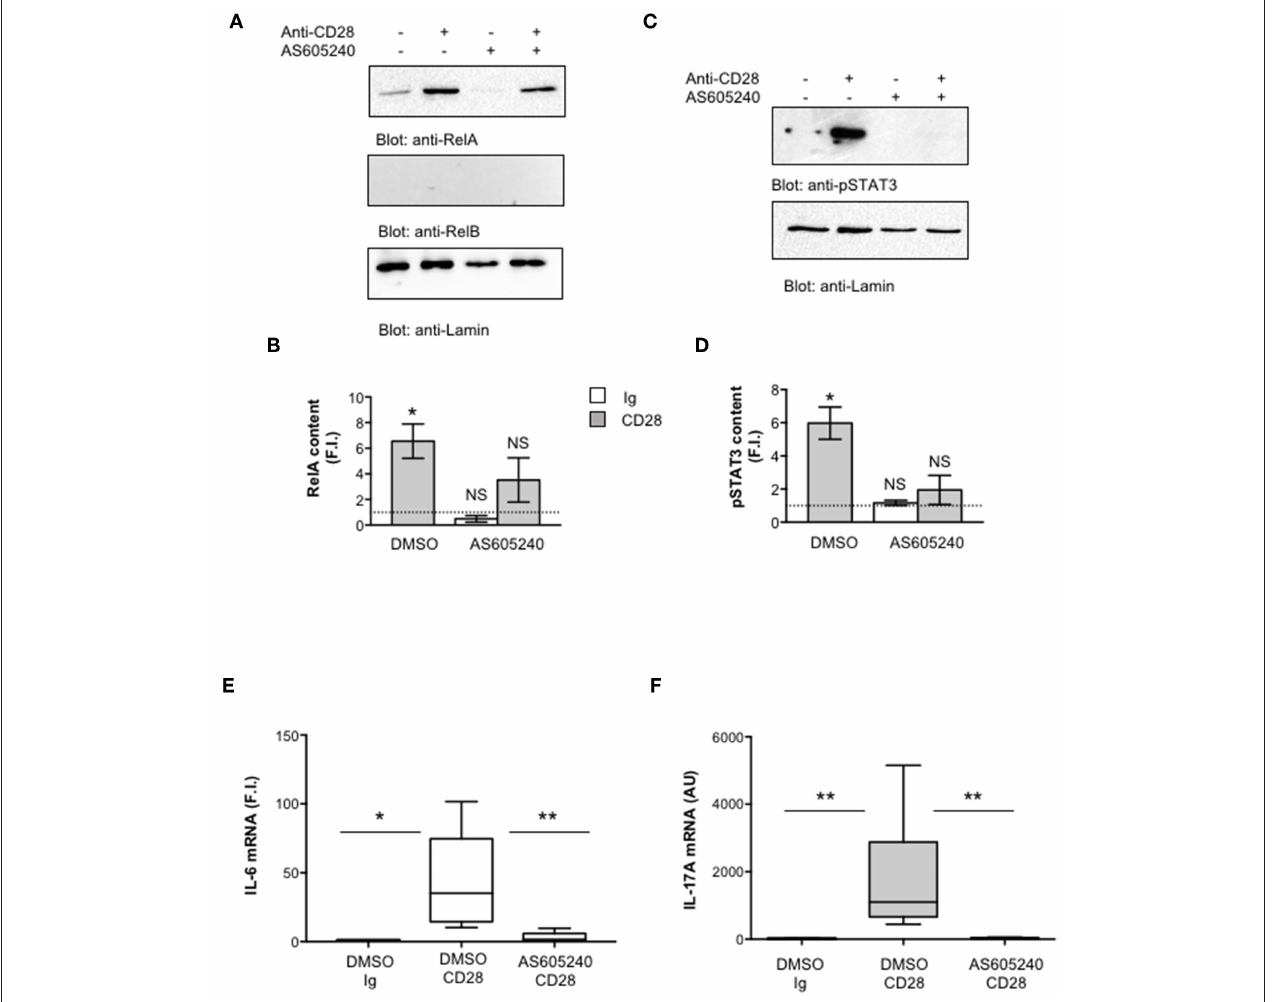
FIGURE 7 | Inhibition of class 1 PI3K activity impairs pSTAT3 and RelA nuclear translocations as well as IL-6 and IL-17A gene expression induced by CD28 stimulation. (A,B) CD4 + T cells were treated with DMSO, as vehicle control, or 10 µ M AS605240 and then stimulated for 3h with isotype control Ig or anti-CD28.2 Abs. RelA, RelB, and lamin A/C (A) as well as pSTAT3 and lamin B1 (B) levels in nuclear extracts were analyzed by western blotting. RelA (C) and pSTAT3 (D) fold inductions (F.I.) were quantified by densitometric analysis and normalized to lamin levels. Bars represent mean F.I. ± SEM of three (C) or two (D) HD. Significance was calculated by Student t -test. * p < 0.05. NS, not significant. (E,F) IL-6 (E) and IL-17A (F) mRNA levels of CD4 + T cell from HD ( n = 5) treated with DMSO, as vehicle control, or AS605240 and stimulated for 6h (E) or 24h (F) with isotype control Ig or anti-CD28.2 Abs. The values were normalized to GAPDH and expressed fold inductions (F.I.) over control Ig-stimulated cells (E) or AU (F) . Lines represent median values and statistical significance was calculated by Student t -test (E) or Mann-Whitney test (F) . * p < 0.05, ** p < 0.01. Median values: IL-6, DMSO Ig = 1, DMSO CD28 = 35.14, AS605240 CD28 = 1.5; IL-17A, DMSO Ig = 11, DMSO CD28 = 1,776, AS605240 CD28 =